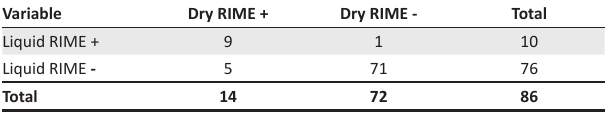
TABLE 2: Diagnostic performance of dry repetitive insertion mobile element loop-mediated isothermal amplification against liquid repetitive insertion mobile element loop-mediated isothermal amplification for the detection of trypanosomes.